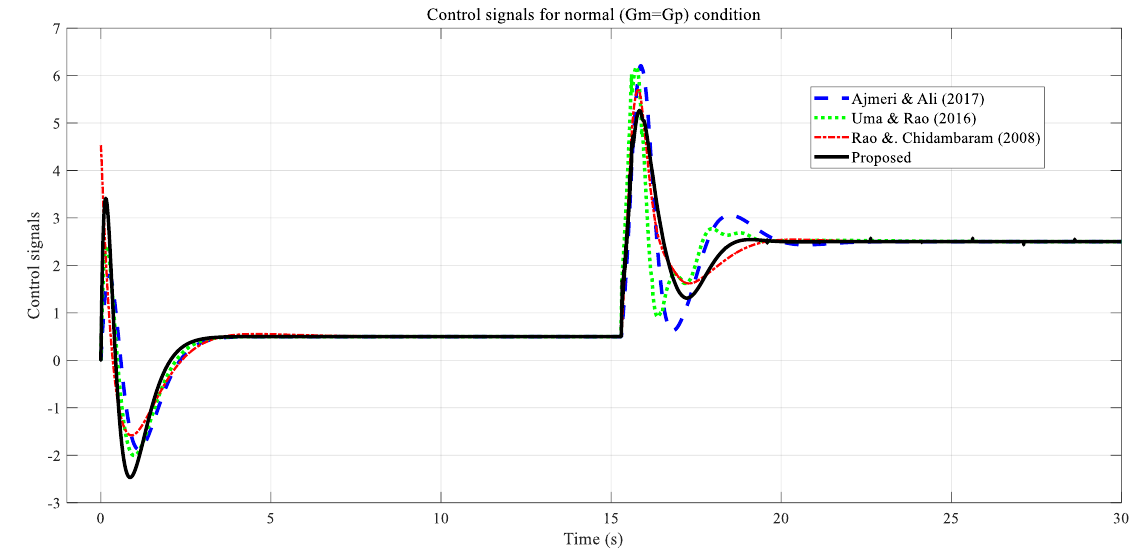
Figure 5. Control signals of the proposed method and other methods for Example 1 [15,16,18].